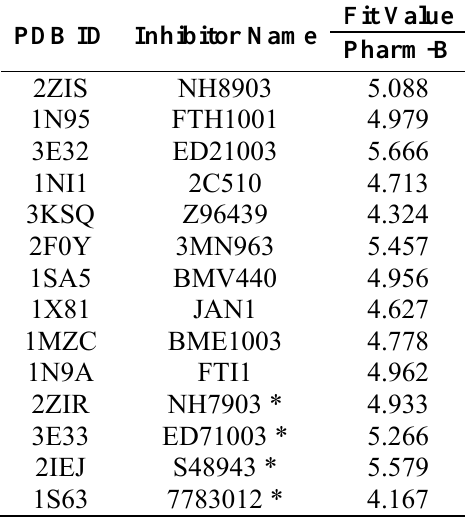
Table 3. Best-fit values of the training and test set compounds based on structure based pharmacophore techniques.